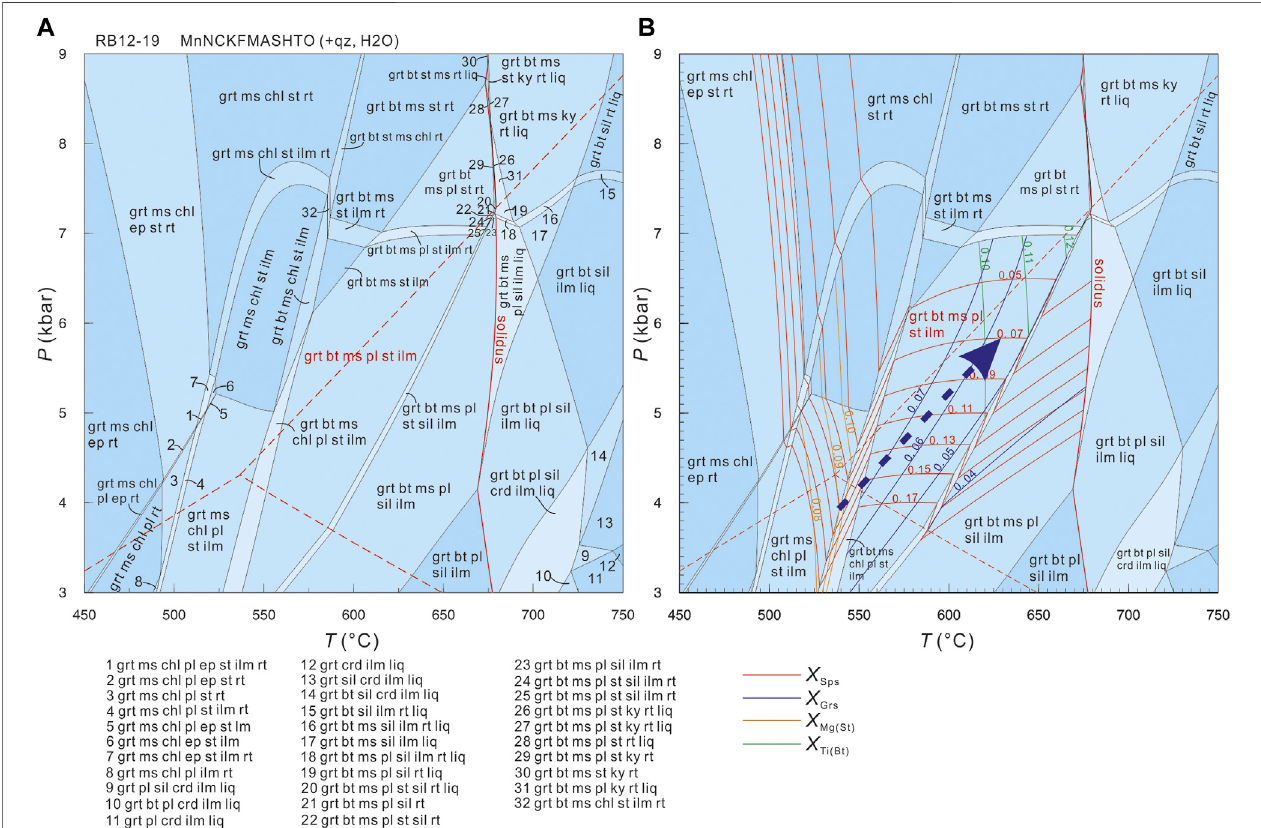
FIGURE 7 | P – T pseudosections for the garnet – staurolite – two-mica schist sample RB12-19. (A) P – T pseudosection that shows mineral assemblages. (B) P – T pseudosection with isopleths of X Sps and X Grs in garnet, X Mg in staurolite, and X Ti in biotite. The fi eld of peak mineral assemblage is marked by grt – bt – ms – pl – st – ilm – qz – H 2 O in red type.